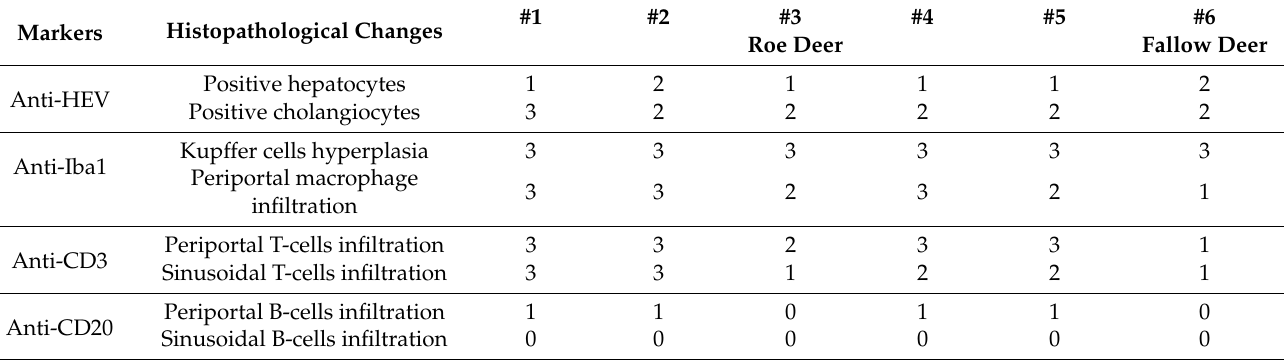
Table 5. Results of the immunohistochemical investigation conducted on the six liver samples that scored positive for RT-qPCR. 0 = absence; 1 = slight presence; 2 = moderate presence; 3 = strong